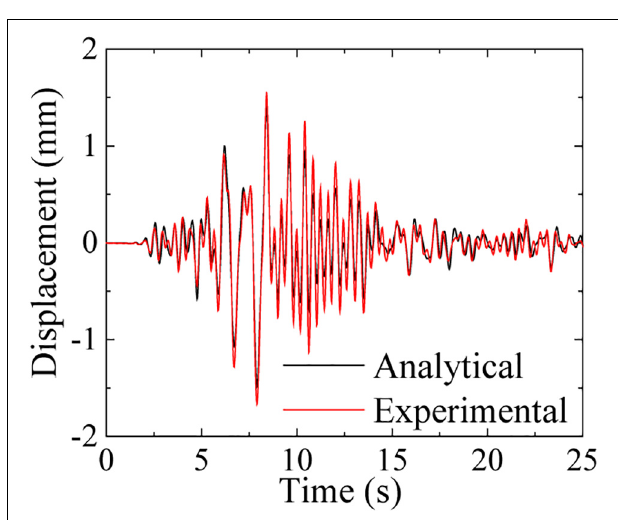
FIGURE 7 | Time histories of the shear force and deformation (standard case).